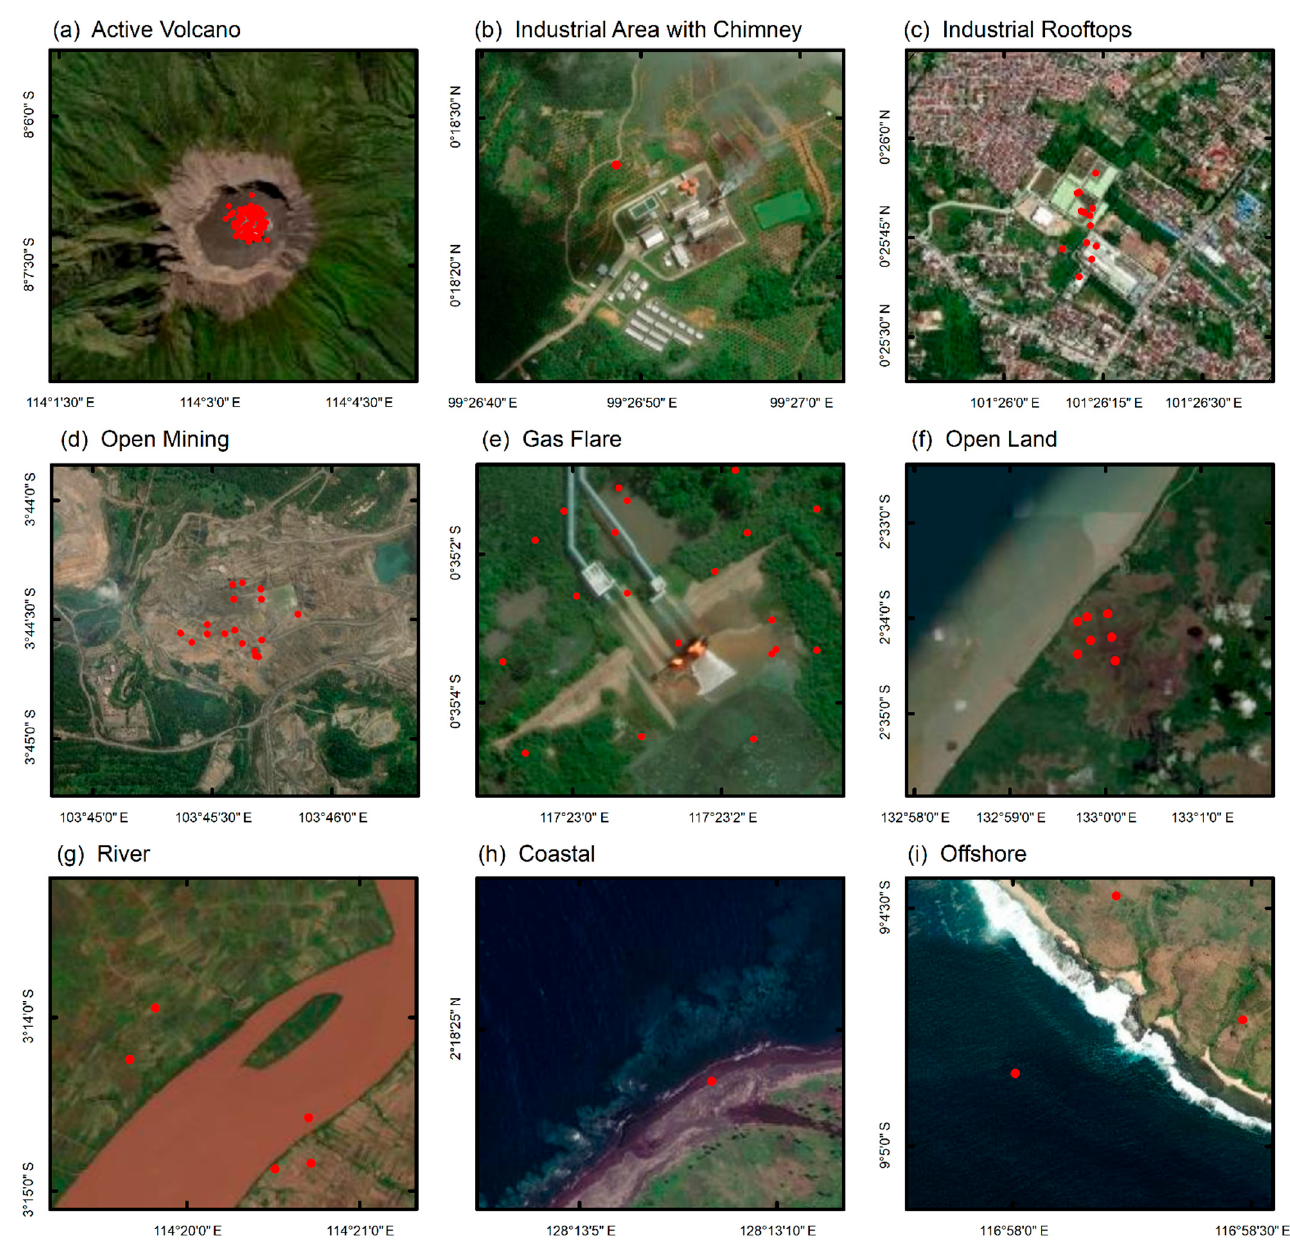
Figure 5. Examples of false-positive objects for biomass fire. The VNP14IMGML type 1 to type 3 period of 2018–2020 was overlaid on high-spatial-resolution images. The red dots represents the points of false-positive active fires.